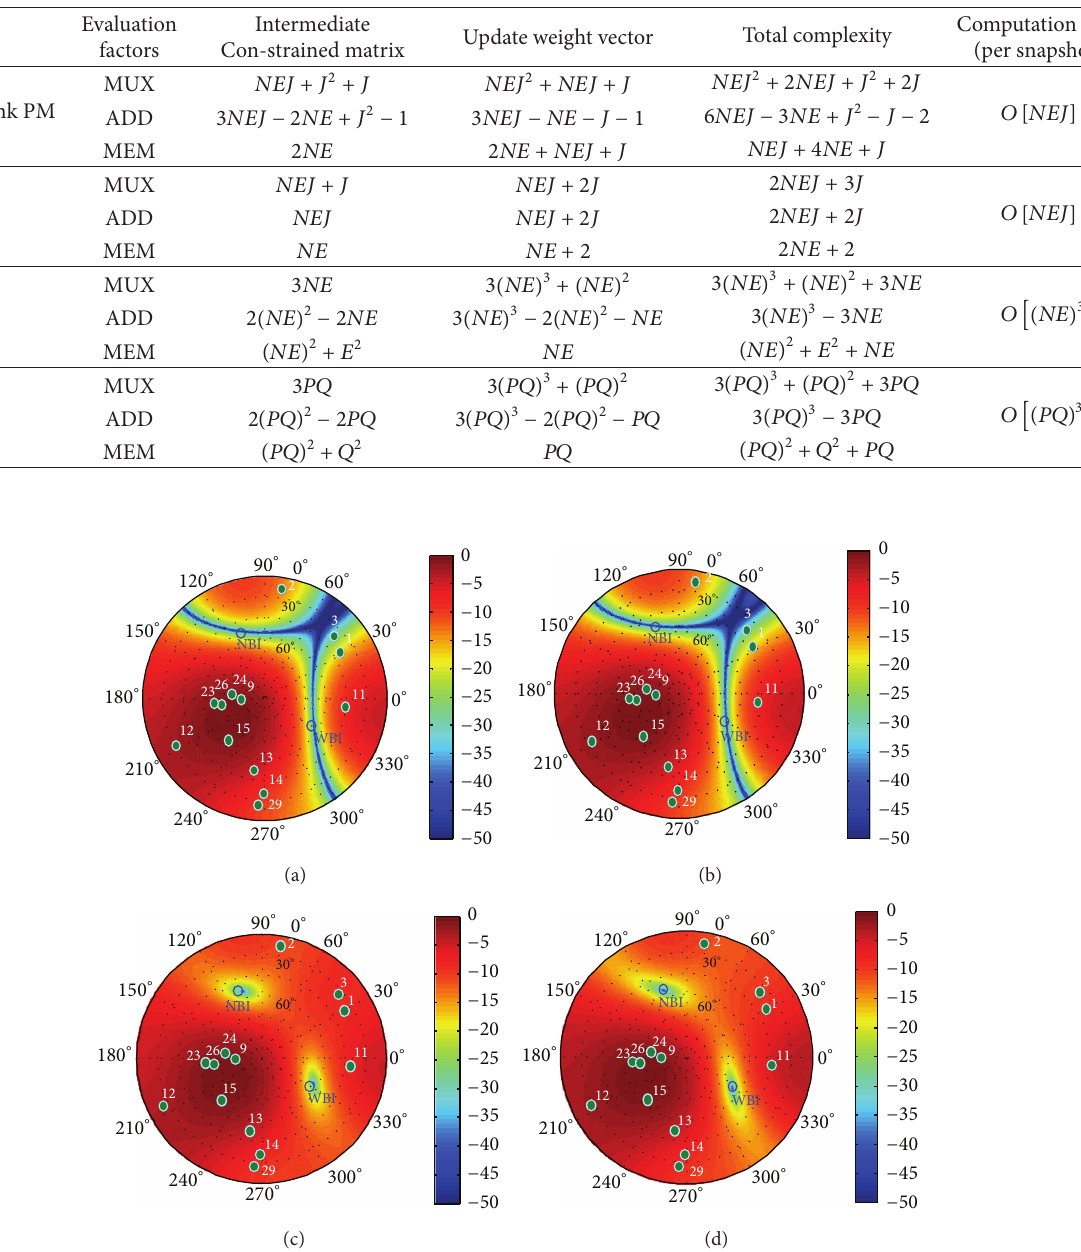
Table 2: Complexity comparison of STAP algorithms in different update procedures.